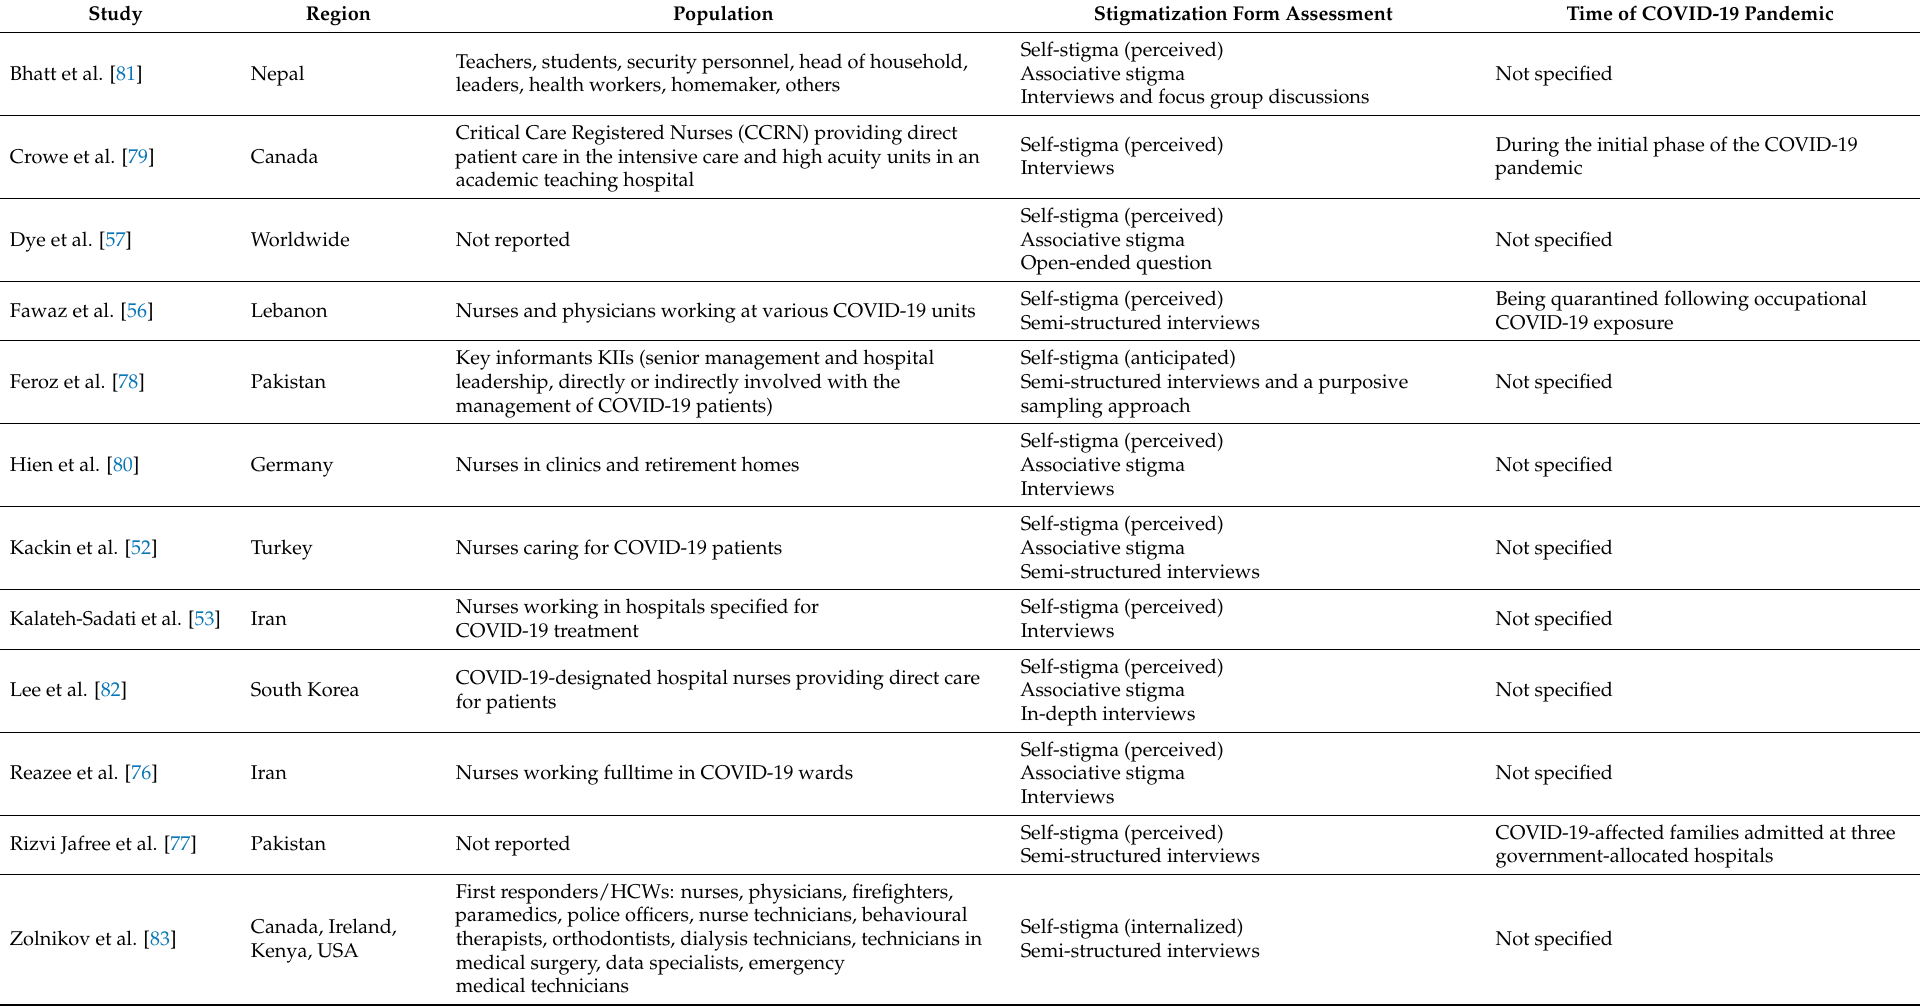
Table 5. Summary of included qualitative